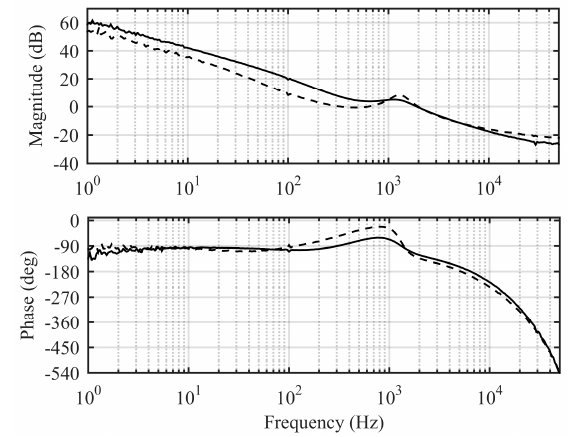
Figure 21. Measured output-voltage loop gain of the boost converter in Figure 19.